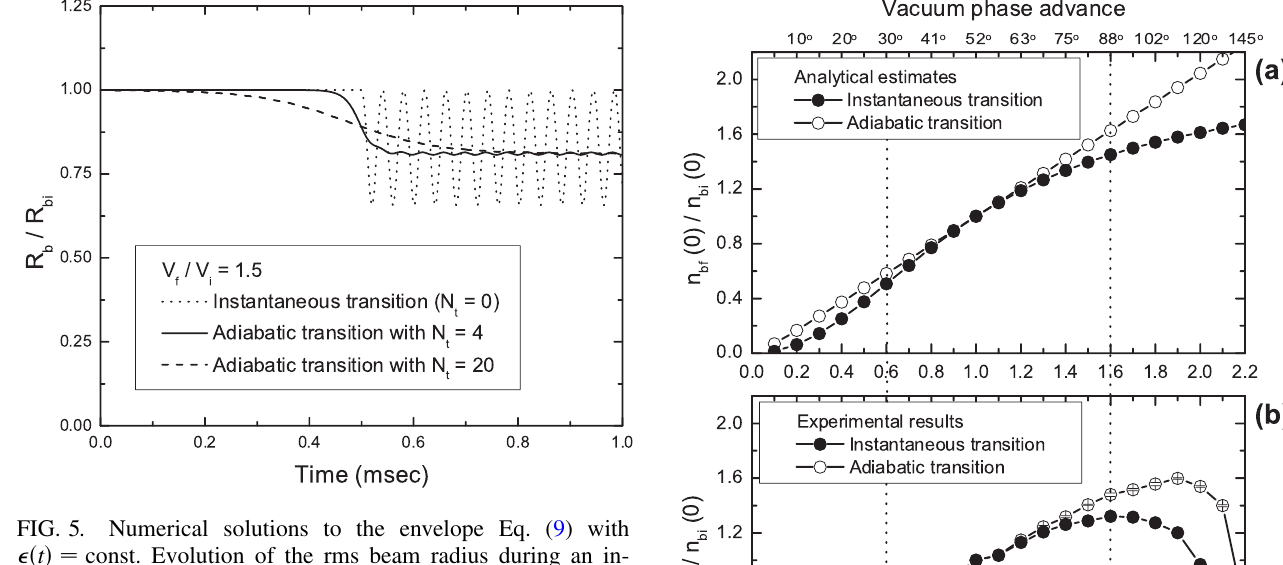
=V with f (cid:2) 60 kH z . f i (cid:2) 49 : 8 (cid:3) . vi